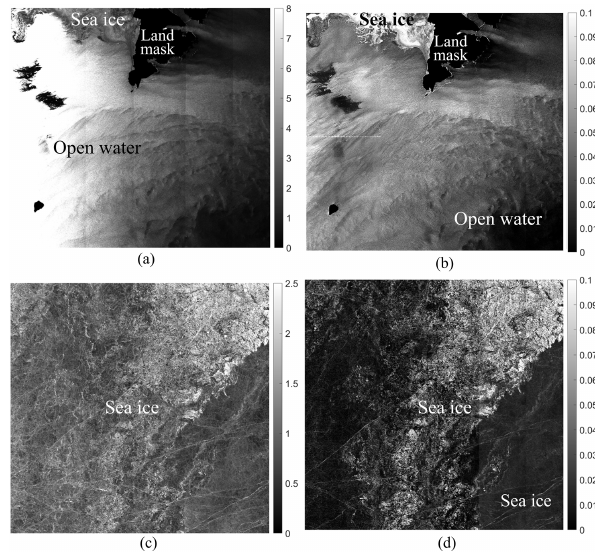
Figure 3. Example of the denoising process. (a) The origi- nal S1 EW HH-polarized image. (b) S1 EW HH-polarized im- age after an incidence angle correction. (c) The original S1 EW HV-polarized image. (d) Denoised S1 EW HV-polarized image using the denoising method (Li, 2020). (Image ID: S1B_EW_GRDM_1SDH_20180711T073522_ 20180711T073622_011760_015A2A_4965).